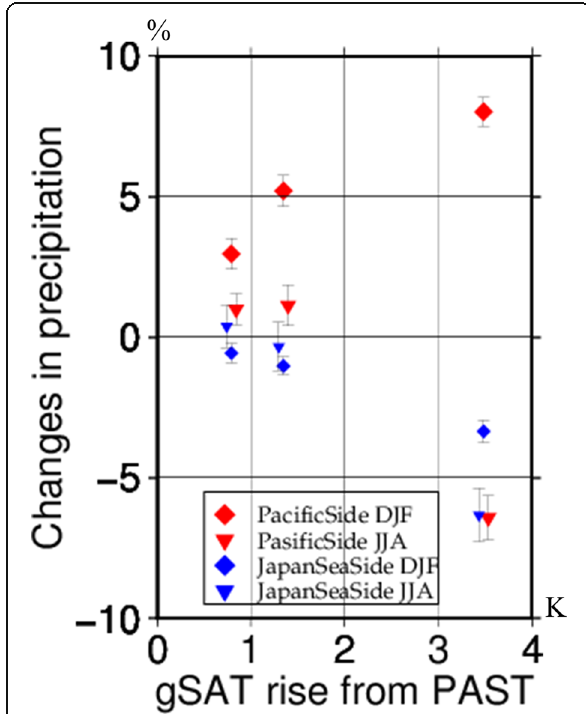
Fig. 8 Future changes (%) in seasonal precipitation amounts separately for the Pacific area side and the Japan Sea side areas in Honshu. The red and blue colors indicate the Pacific side and the Japan Sea side, respectively. The squares and triangles indicate DJF and JJA, respectively. The error bars denote the standard errors of the ensemble